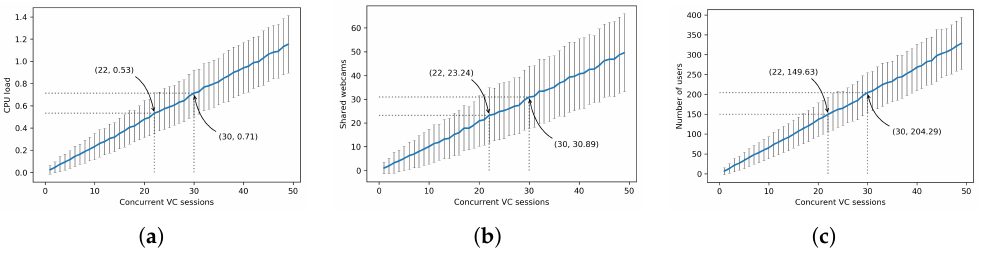
Figure 9. Simulated server capacity for concurrent VC sessions. ( a ) CPU loads; ( b ) Shared webcams; ( c )